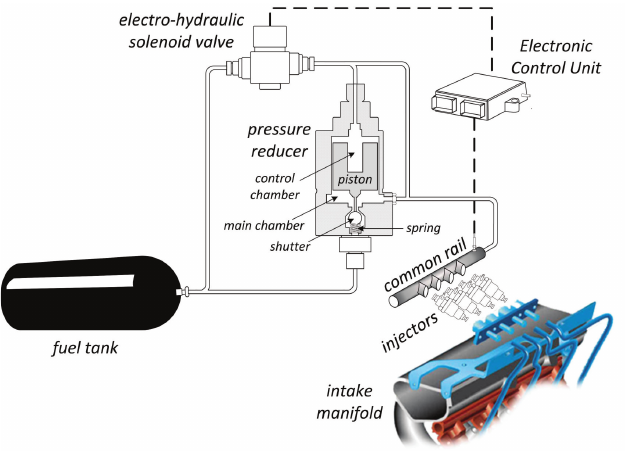
Figure 5. Representation of the gas-injection